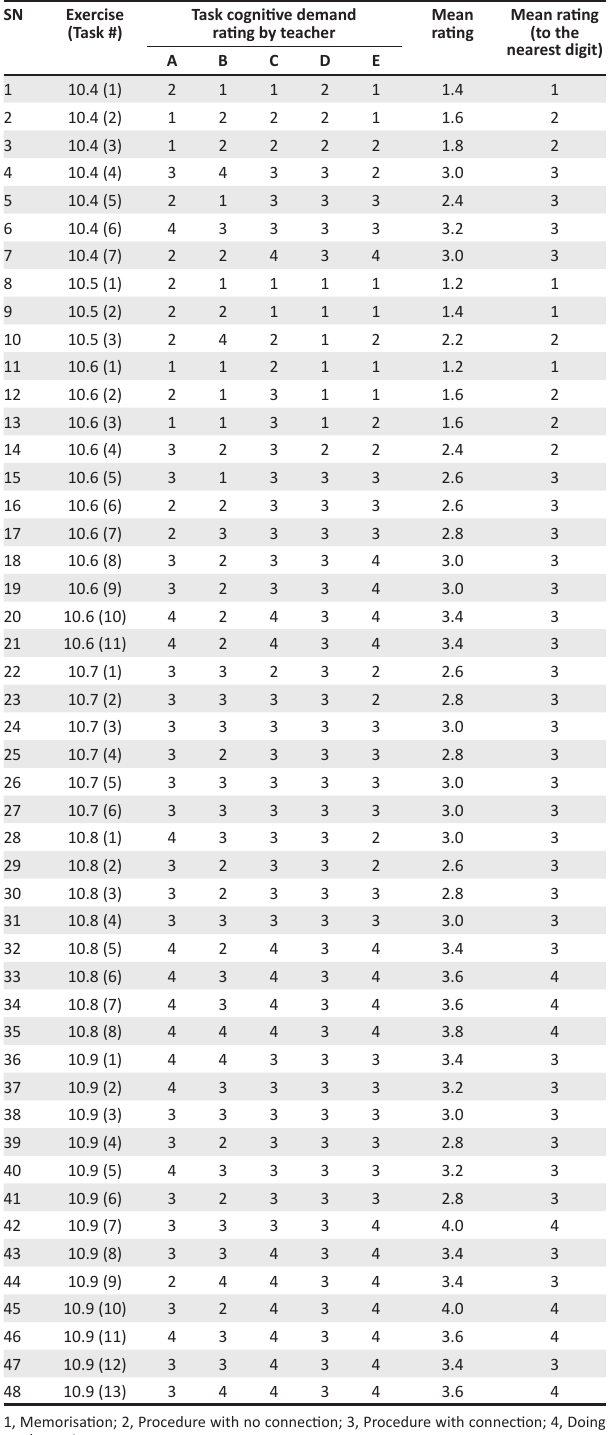
TABLE 2: Cognitive demand rating of 48 probability and counting principles tasks in the digital textbook by five senior mathematics teachers. SN Exercise (Task